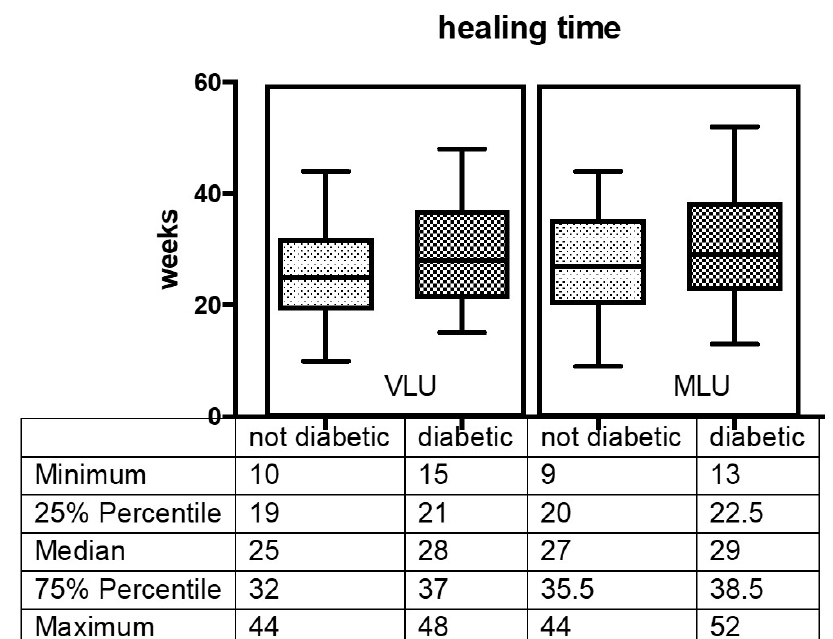
Figure 2. Ulcer healing time in diabetic patients and not diabetic patients with Venous Leg Ulcer and with Mixed Leg Ulcer.